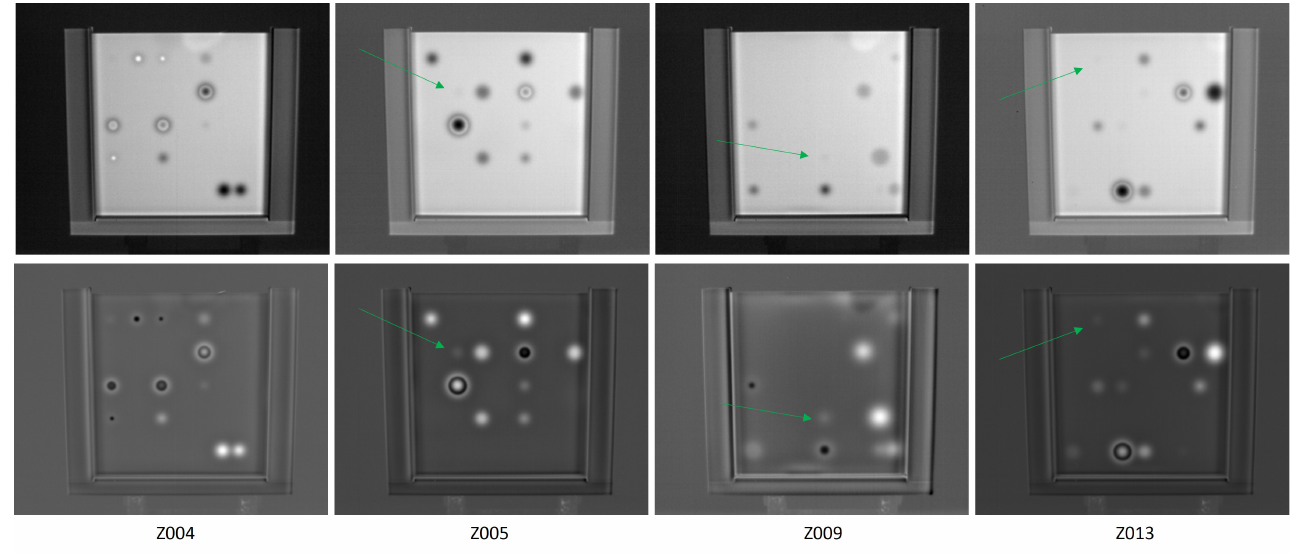
Figure 5. PPT images (first row) and PCT images (second row) for four specimens. The green arrows indicate areas of defects with greater contrast in the PCT images compared to the PPT